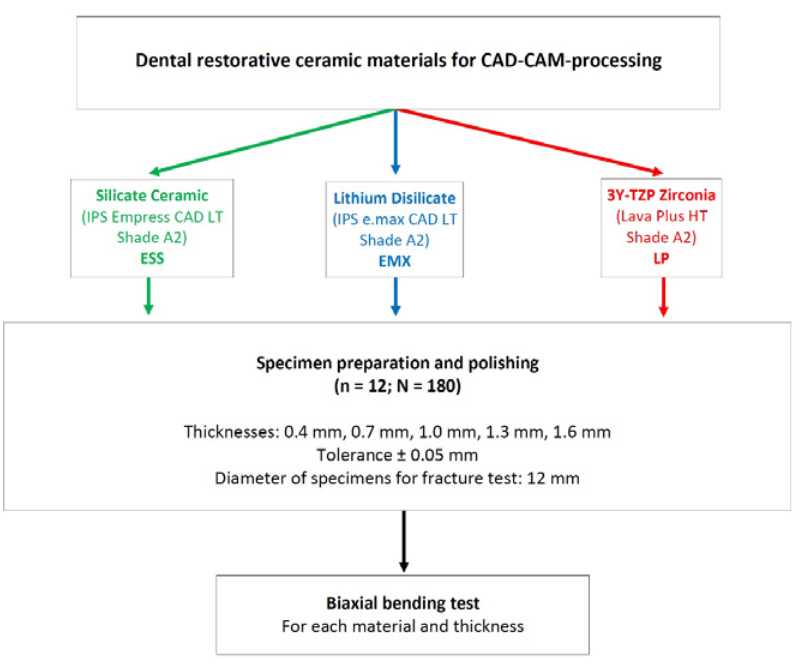
Figure 1. Study design and setup. Table 1. Details of the dental ceramics evaluated.